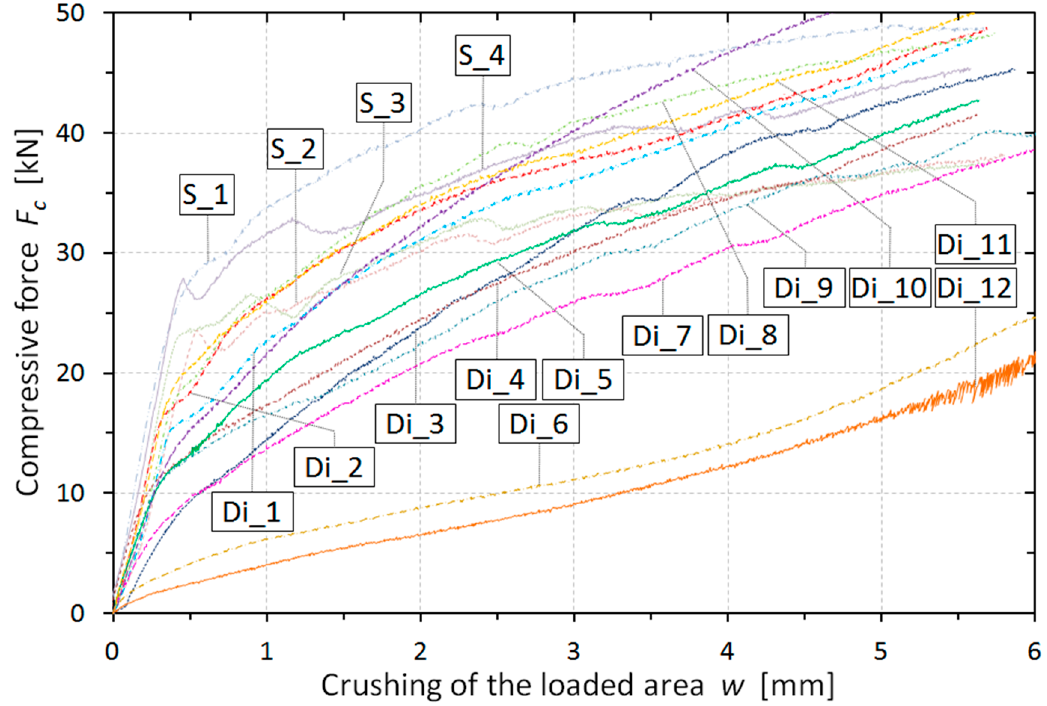
Figure 8. Compressive force-displacement curves perpendicular to the grain for the 4 sound (S) and 12 insect-deteriorated (Di) timber samples tested under monotonic compression.